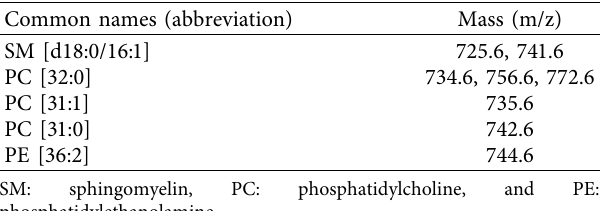
Figure 3: MALDI-MSI of metastatic lesions. (a) Upexpression of m/z species and (b) downexpression of m/z species in liver cancer metastatic lesions. The top panel is the hematoxylin-stained image. MALDI-MSI is the image showing the significant difference between the metastatic lesions and normal tissues at the specific mass. Table 2: Identification of mass obtained from liver cancer meta- static